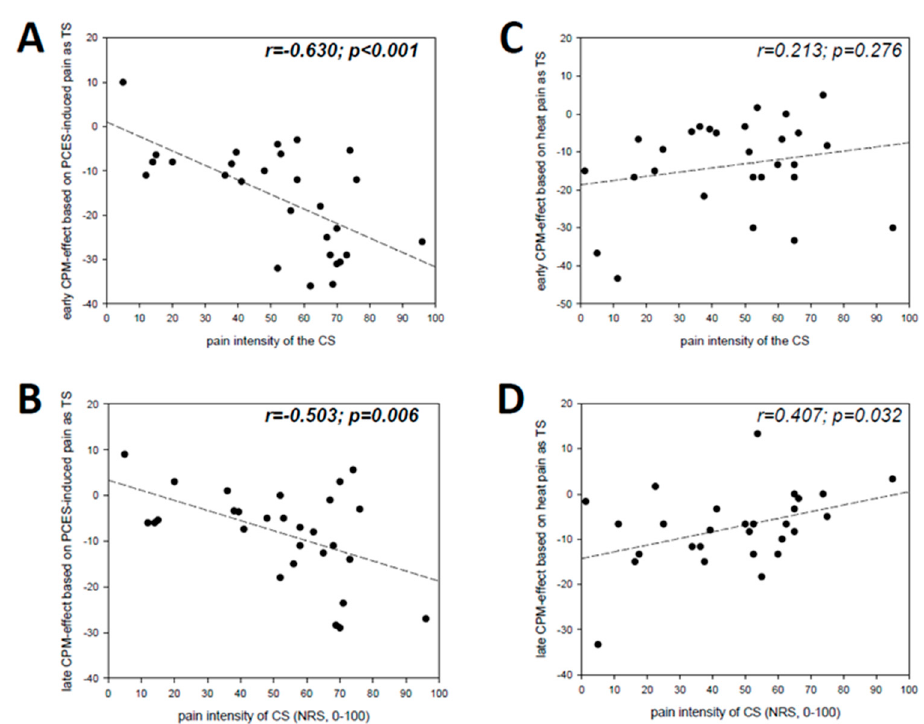
Figure 5. Scatter plot displaying correlations between the pain intensity of the conditioning stimulus with the ( A ) early and ( B ) late CPM-effect based PCES-induced pain as TS as well as with the ( C ) early and ( D ) late CPM-effect based on heat pain as TS.